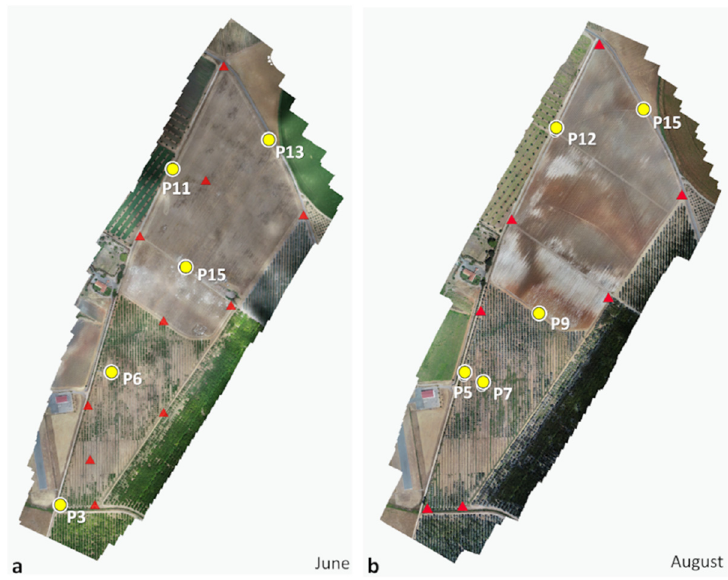
Figure 9. GCPs (red triangles) used for SfM processing and ICPs (yellow circles) used for accuracy assessment. Disposition of GCPs and ICPs in the June block ( a ) and August block ( b ).